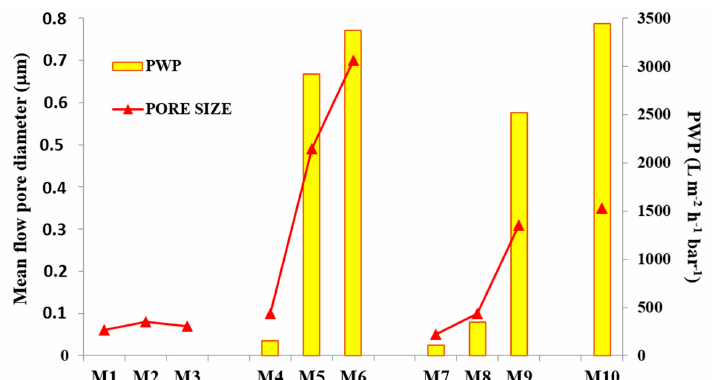
Figure 9. Pure water permeability (PWP) correlated with pore size diameter. Standard deviation was less than 5% in all operative conditions. Membrane porosity is strictly correlated with the membranes’ morphology. All the membranes prepared with the casting solution composed of PVDF and TEP (M1–M3), exhibited a porosity near to or lower than ~80%, which is in accordance with the SEM images shown in Figure 3. On the contrary, by adding PVP and PEG to the dope solution, the resulting membrane presented a higher porosity, which further increased with the presence of GO, reaching a value of ~87%. However, a GO content of 0.5 wt % caused a reduction in porosity for M10, probably due to the blocking of pores by catalyst nanosheets’ aggregation. The results of the tensile strength and elongation tests are shown in Table 5. The Young’s modulus for all of the membranes was improved when GO, together with